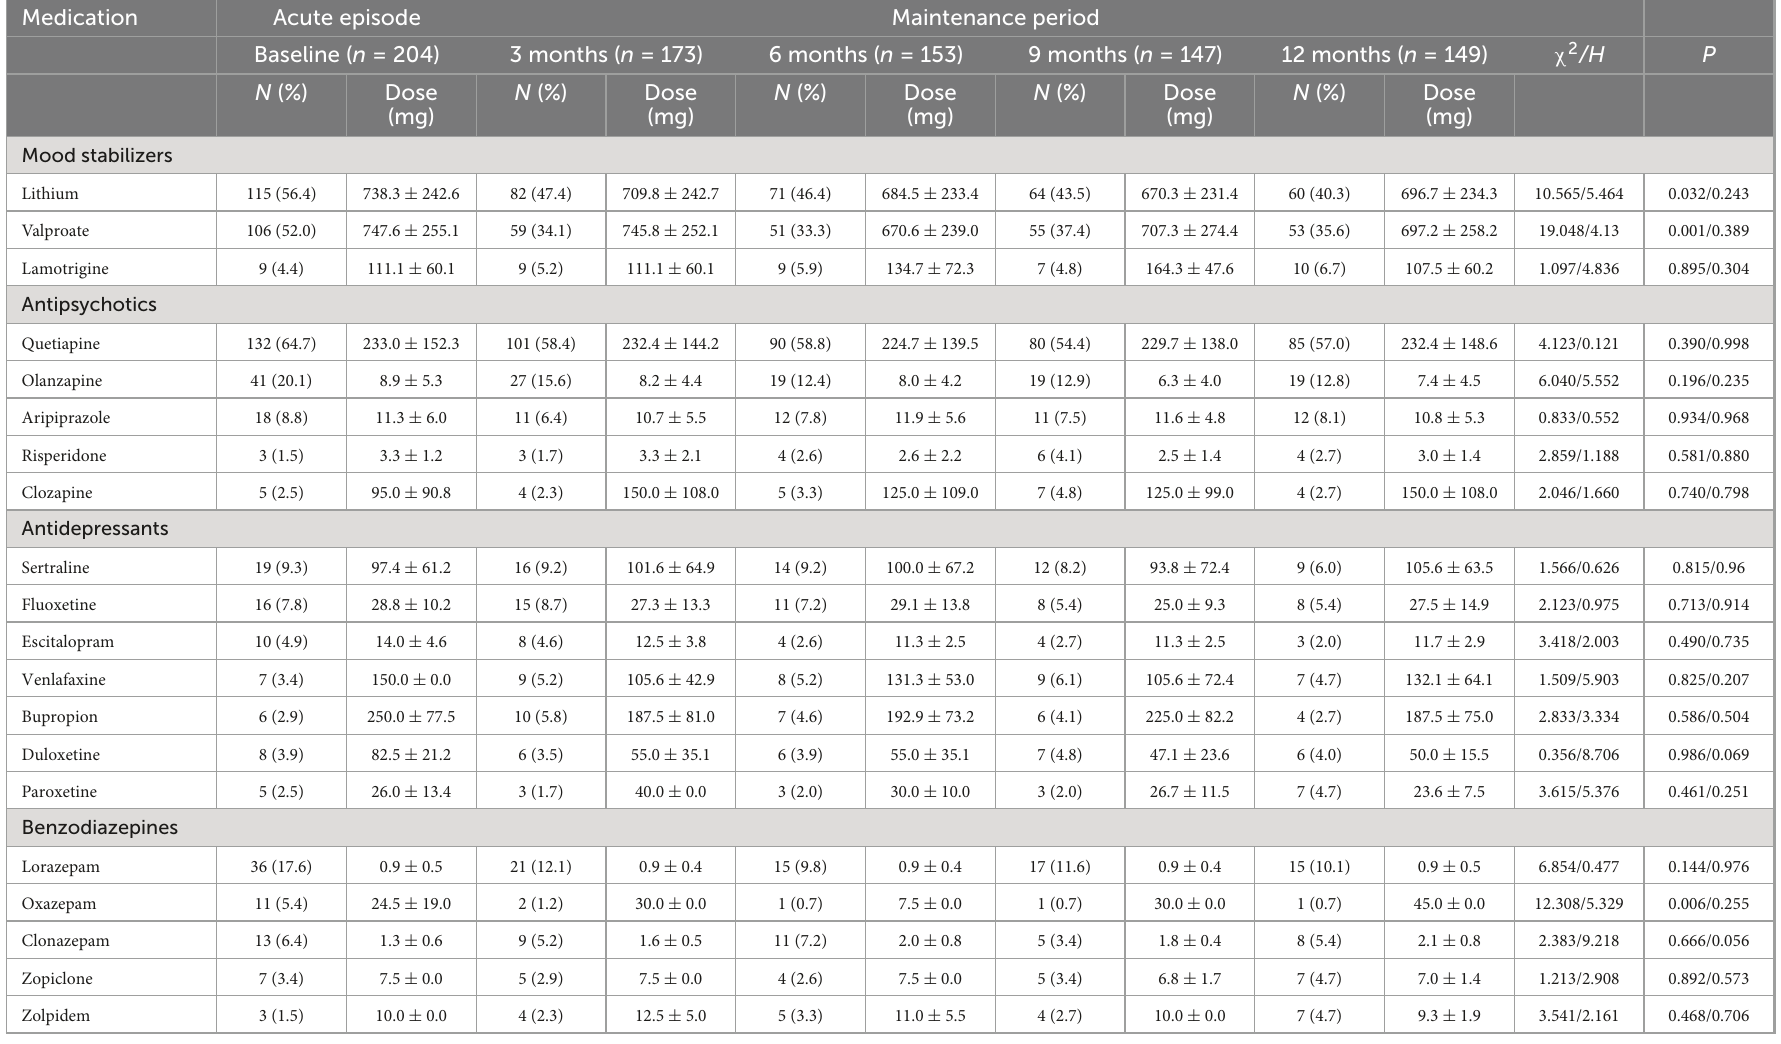
TABLE 3 The most commonly used drugs and their dosages in the treatment of patients with bipolar disorder, expressed as n (%) and mean